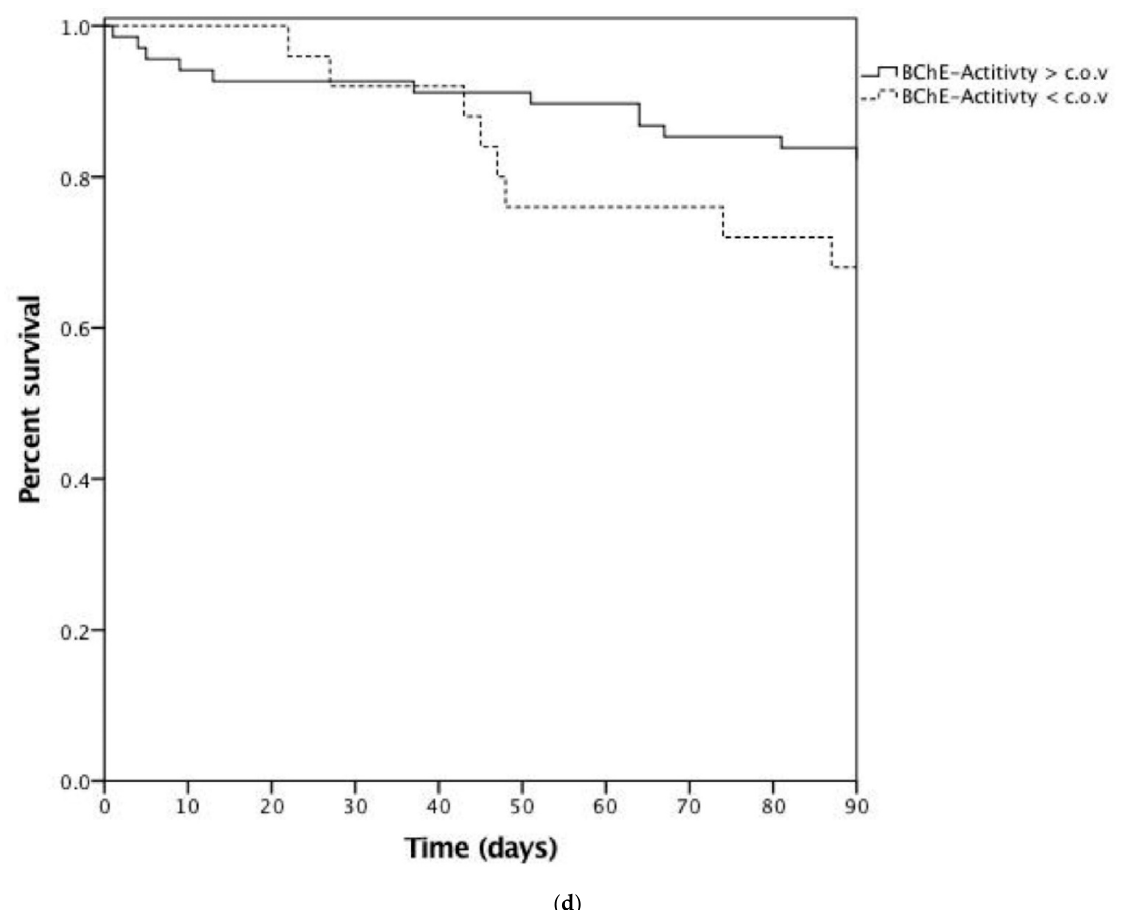
Figure 2. Plasma concentrations of butyrylcholinesterase (BChE) in patients following liver